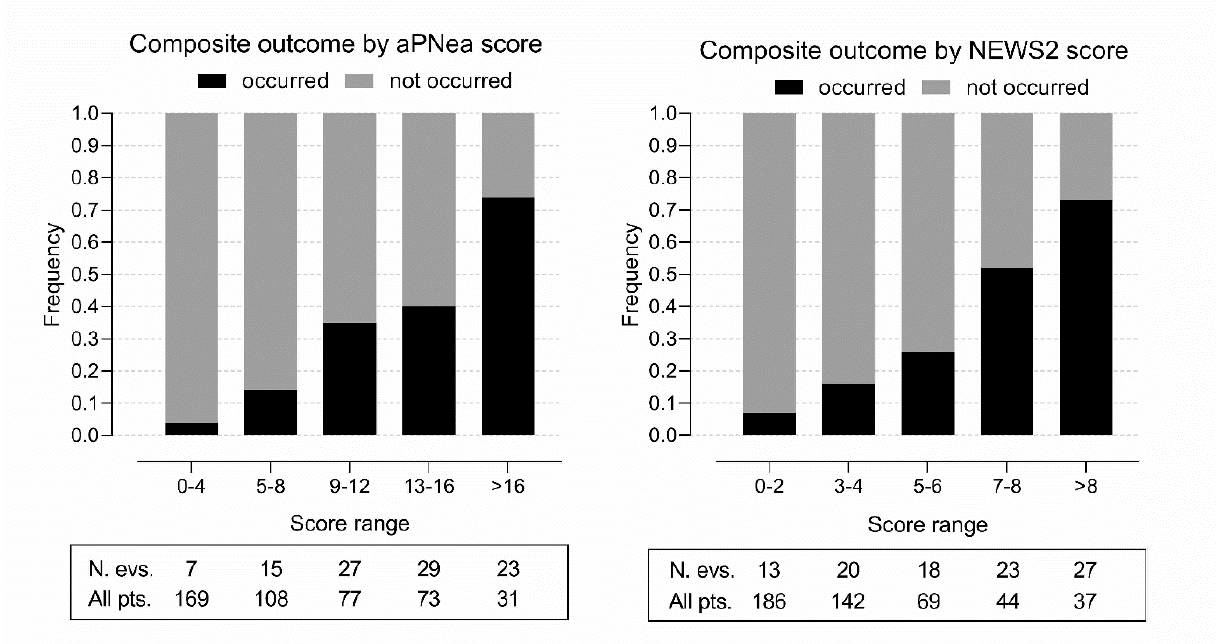
Figure 1. Bar graph presenting the frequency of the composite outcome by the aPNea and NEWS2 score ranges in the hub hospital. Below (rectangle) are reported the number of events (N. evs.) and the number of patients (All pts.) in each score range. Table 2. Variables summary and comparison according to the composite outcome occurrence after follow-up at 30 days in the entire cohort of patients from the hub